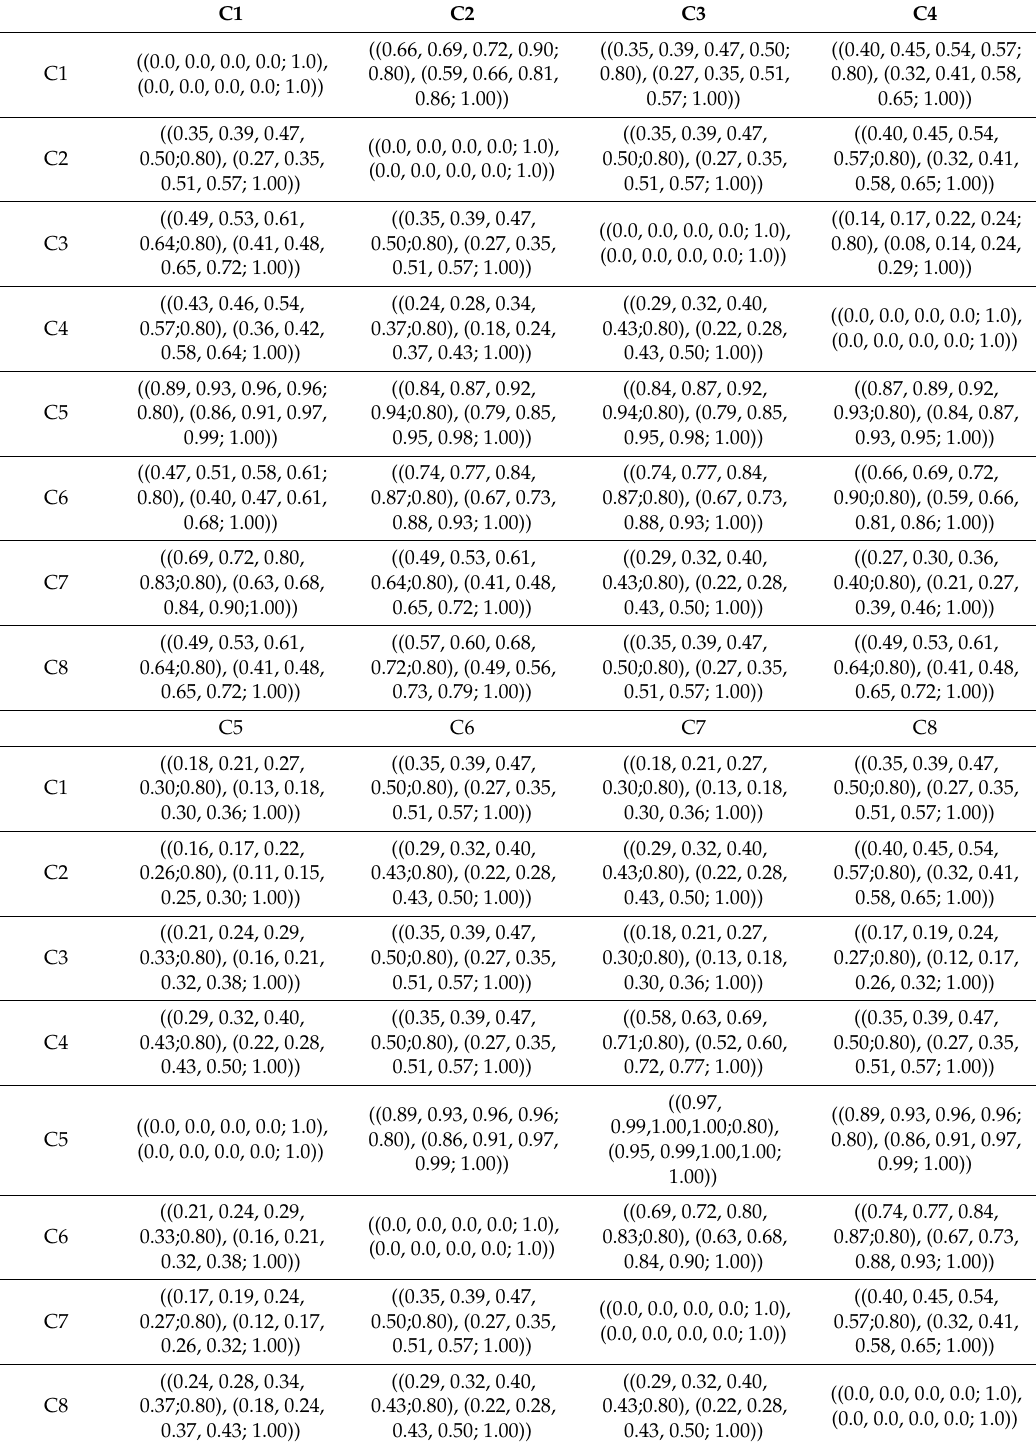
Table 5. Direct-relation